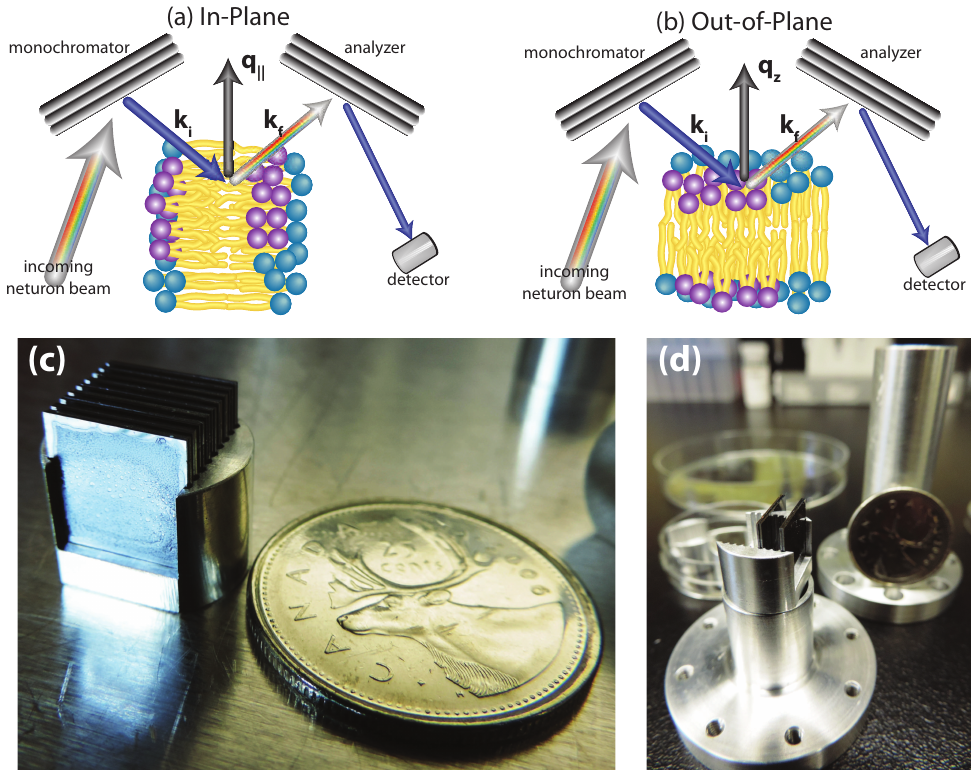
Figure 8. ( a ) and ( b ): Sketch of the scattering geometry to measure in-plane and out-of-plane structure using a triple-axis spectrometer. ( c ) Photo of the solid supported membranes on silicon wafers mounted in a fabricated holder. ( d ) Photo of the aluminum sample can, which was inserted into the cryomagnet. Saturated salt solutions were added to the container underneath the samples to achieve different levels of